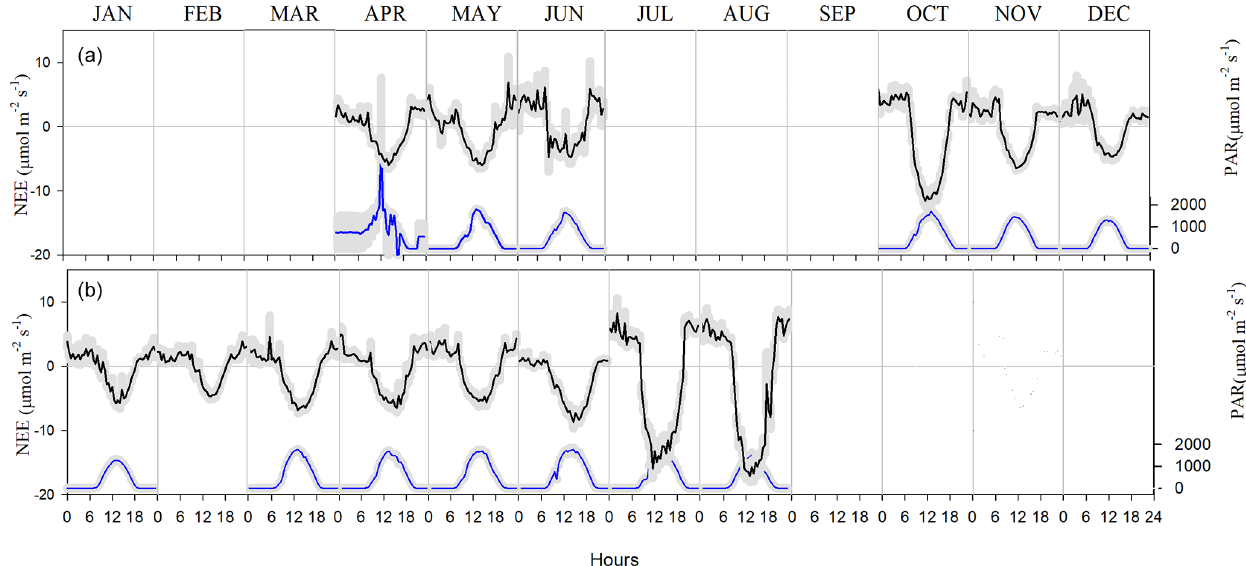
Figure 8. Net ecosystem exchange (NEE) and photosynthetic active radiation (PAR) at the Bernal site in (a) 2017 and (b) 2018. Negative values in the CO 2 flux indicate photosynthesis. The gray shadow is the standard error of the mean for each month at any given hour. Table 3. Leader board of EML models for the Bernal site, using 85% of day observations as training dataset. NA denotes the outcome where the type of model was not present in the 30 top-performing models according to deviance. Type of model Number of models Average deviance All models Top models Leader model Stacked